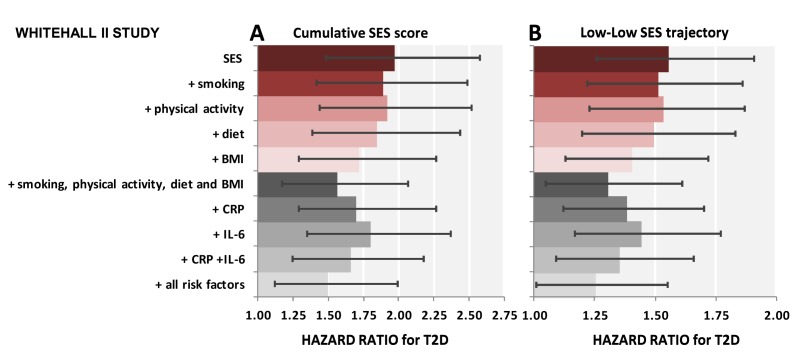
Contribution of smoking, physical activity, diet, BMI, CRP, and IL-6 to the association between lifecourse socioeconomic status and type 2 diabetes incidence.The first bar shows explanatory factors for the associations of low cumulative SES score (ref. high cumulative SES score) (A) and adverse SES-trajectory (ref. high-high SES trajectory) (B) with type 2 diabetes (T2D). Inflammatory markers, in combination, explain 26% (95% CI 16%–46%) of the first association (A) and 34% (95% CI 20%–62%) of the latter association (B). All associations are adjusted for age, sex, ethnicity, family history of T2D, and prevalent conditions. Cumulative SES score includes father's occupational position, participants' education, and participants' occupational position at phase 3. Each SES measure was a 3-level variable with values ranging from 0 (high) to 2 (low). A score was calculated by summing each SES measure (range 0–6). The final cumulative SES score was categorized as high (score = 0–2), middle (score = 3–5), and low (score = 6). Lifecourse SES trajectory refers to father's occupational position and participants' occupational position at phase 3.